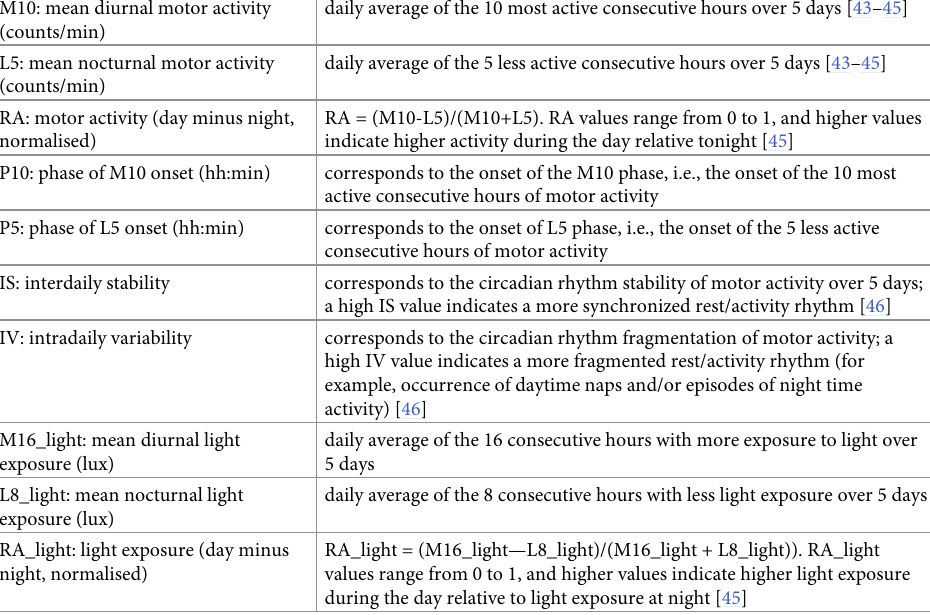
Table 1. Motor activity and light expositions variables obtained from